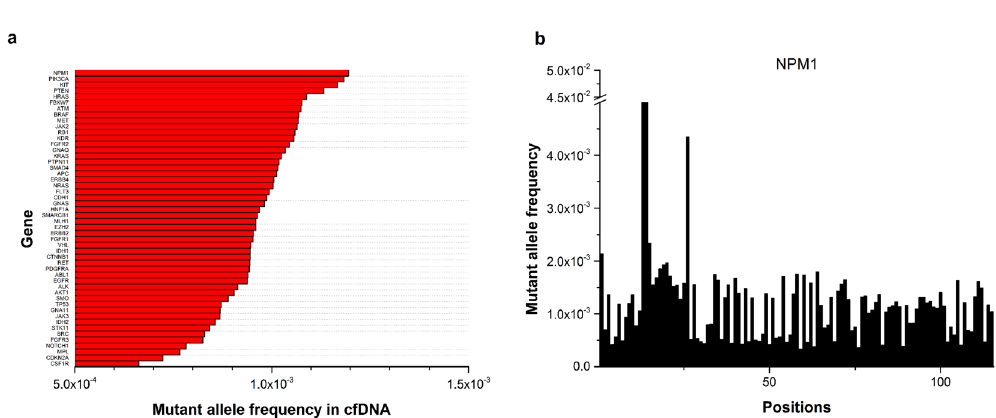
Figure 4. Ranking of the average mutant allele frequency of 50 cancer-associated genes. ( a ) Mutant allele frequency per position for the 50 cancer-associated genes. ( b ) The mutant allele frequency of each position in the NPM1 gene. Here, only one amplicon was designed for NPM1 in our